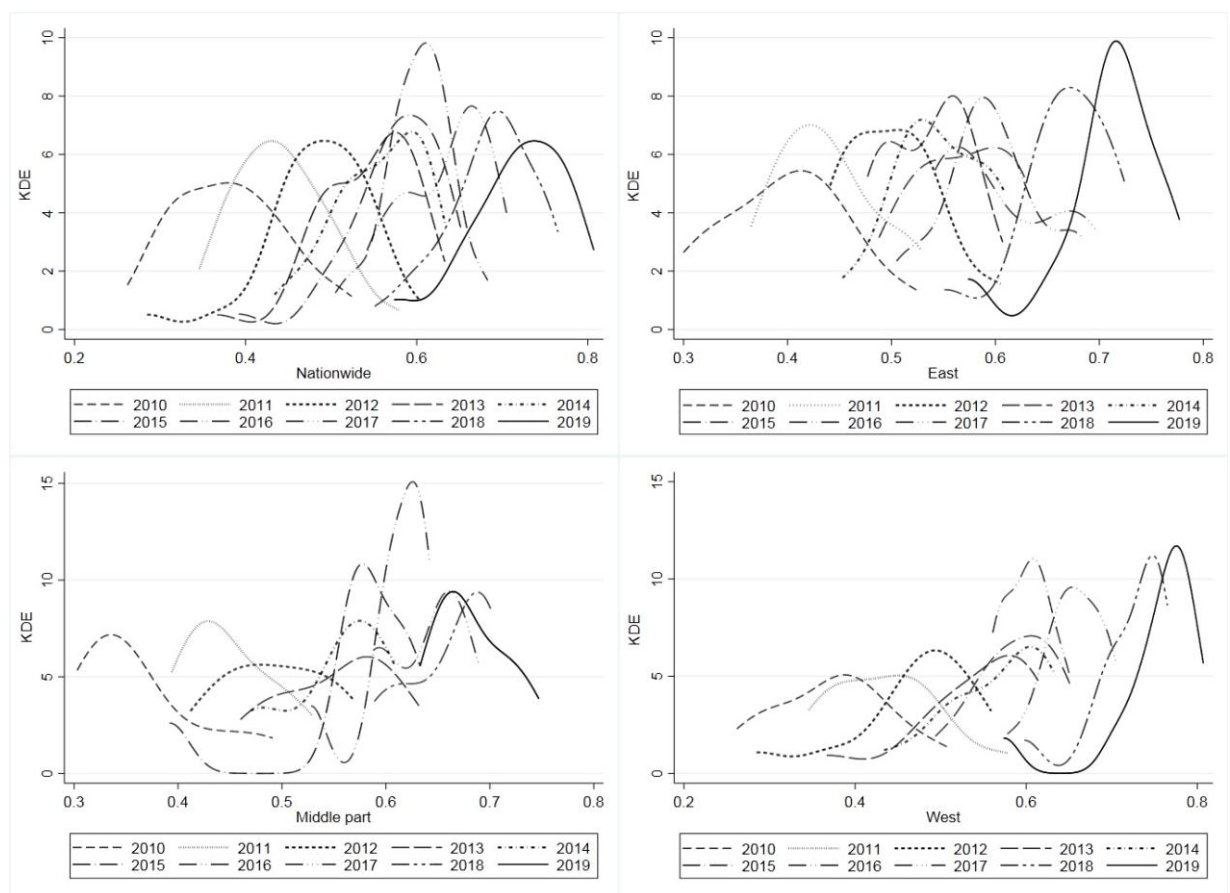
Figure 4. The dynamic evolution of nuclear density of system coordination level by region. Source: own elaboration.